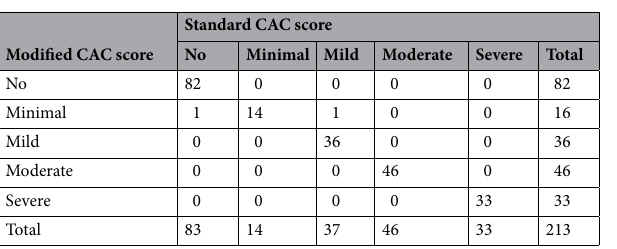
Table 4. Agreement for risk categories between the standard and modified CAC scores from the validation set (κ = 0.994). Data are absolute participant numbers. CAC coronary artery